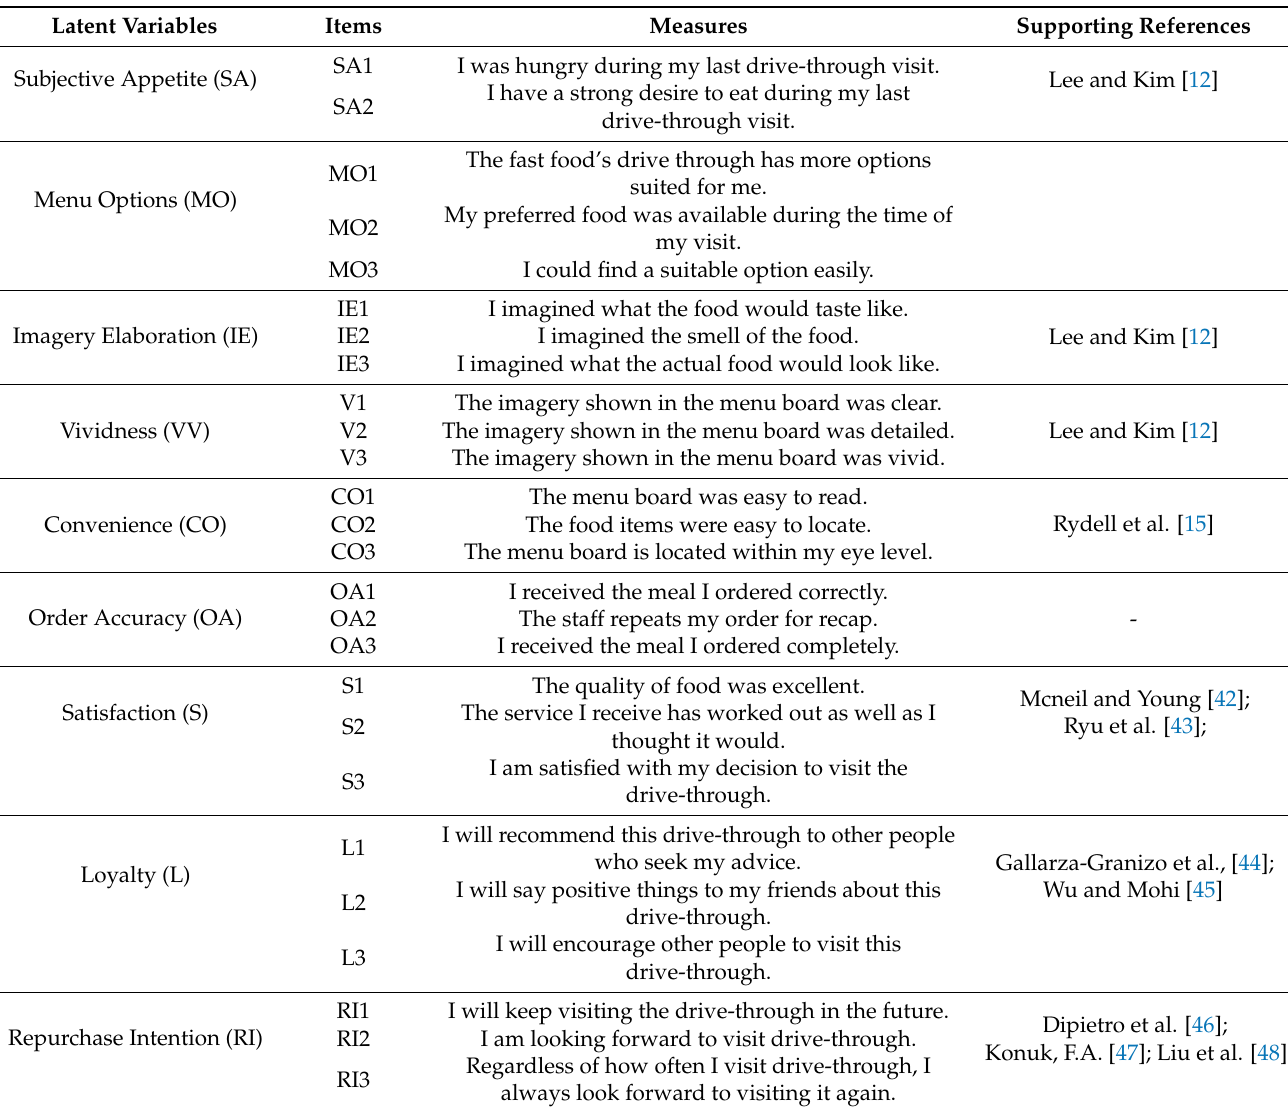
Table 3. The constructs and measurement items included in the